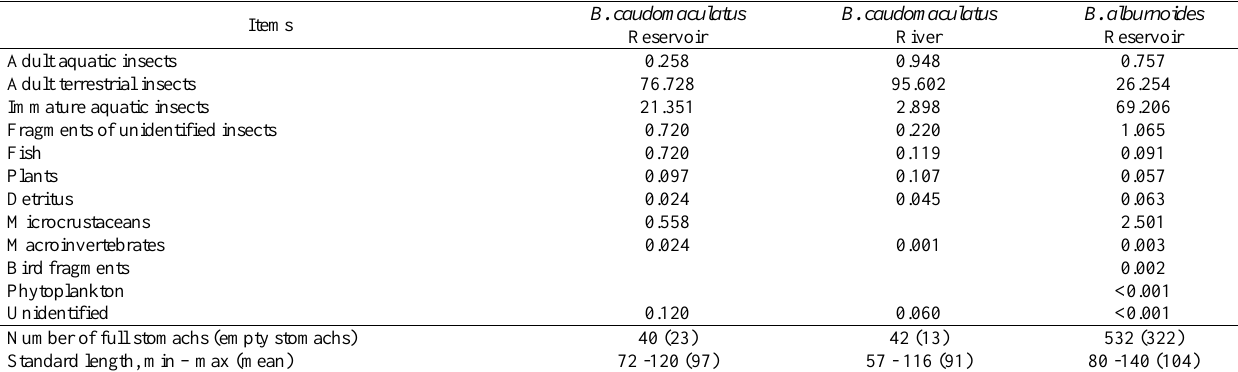
Table 1. Alimentary index (IAi%) based on stomach contents of Bryconops caudomaculatus and B. alburnoides in the region affected by the Balbina Reservoir, Uatumã River, Amazonas State, Brazil. Items